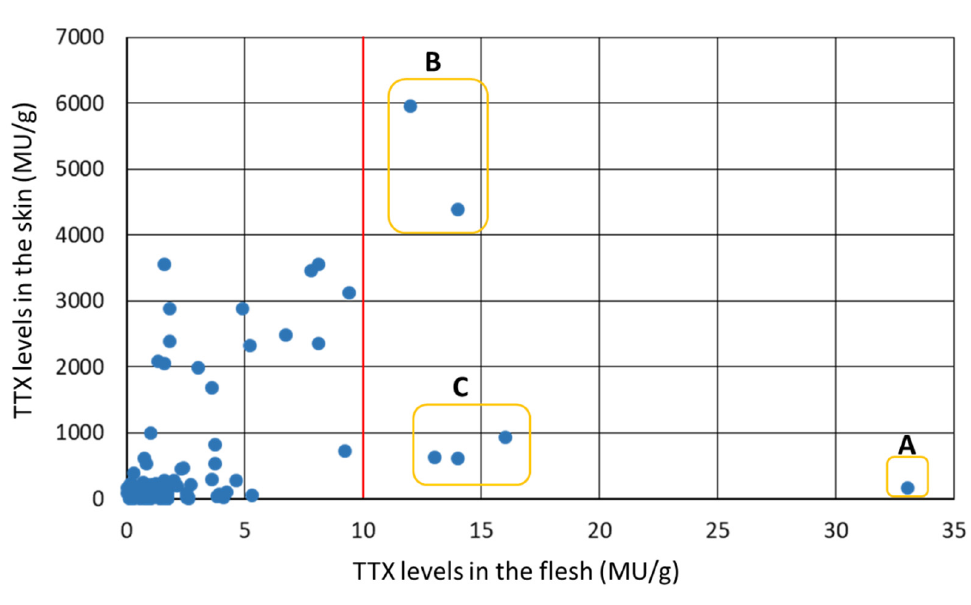
Figure 7. Relationship of TTX levels in the flesh and the skin of the pufferfish, Takifugu flavipterus . A: Specimens with extremely toxic skin; B: specimens were freeze–thawed before cutting into each tissue; C: the condition of the specimen was not good. The red line indicates the level of TTX at 10 MU/g (2.2 mg/kg), the limit of toxicity, in the flesh.